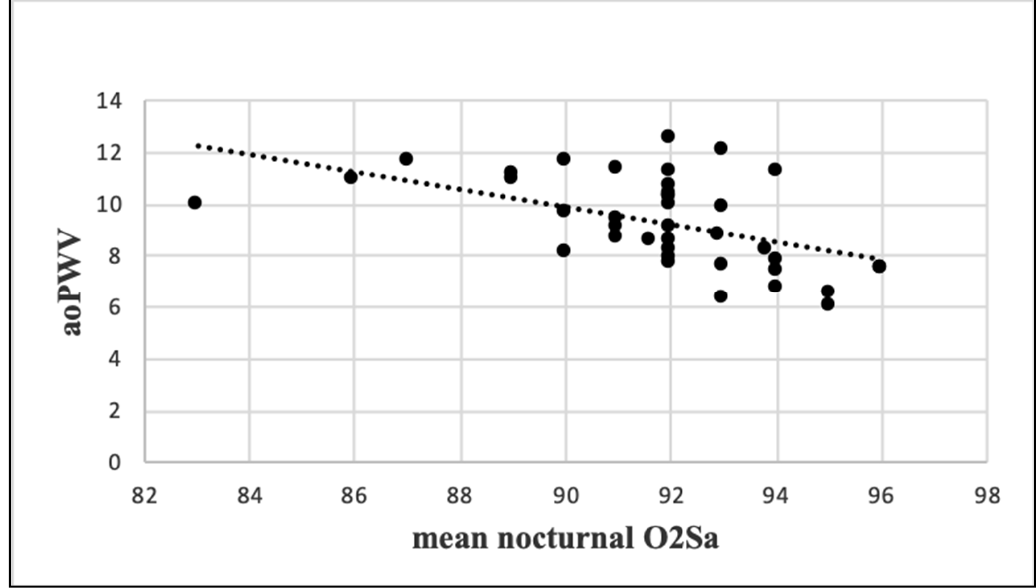
Figure 4. Correlation between aoPWV and mean nocturnal O2Sa. aoPWV: aortic pulse wave velocity; O 2 Sa: oxygen saturation.